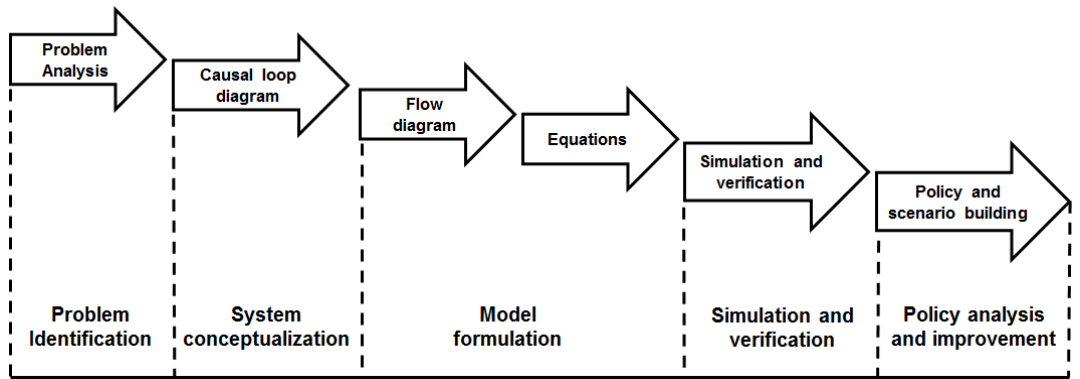
Figure 1. Steps to build an system dynamics simulation model (SDSM) based on the work in